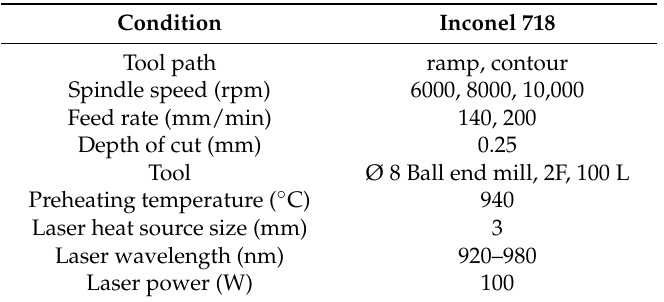
Table 6. Experimental conditions for laser-assisted milling (LAM).